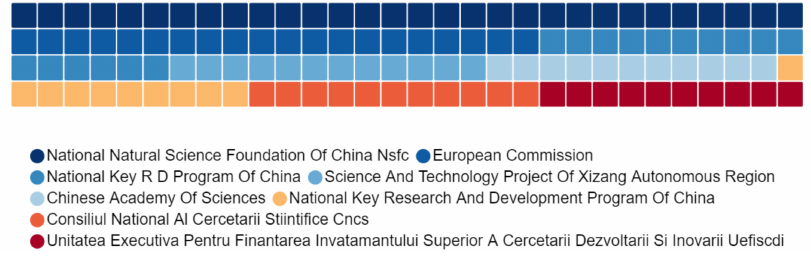
Figure 6. Institutions providing funds for more than five